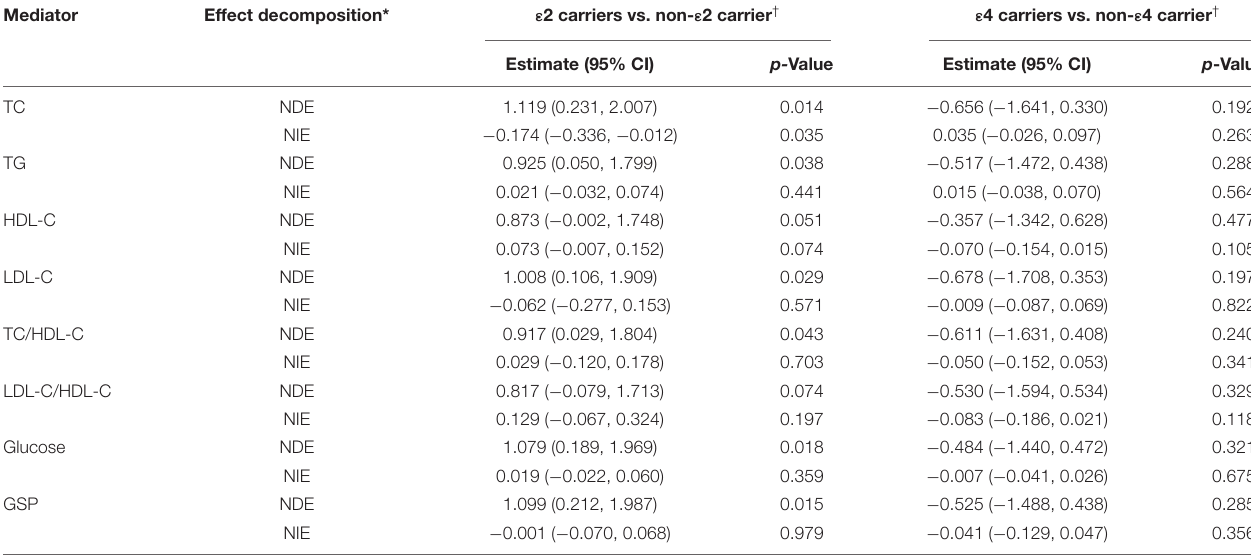
TABLE 5 | The direct and indirect effect through the lipids/glucose of APOE on cognitive function (MMSE continuous score).